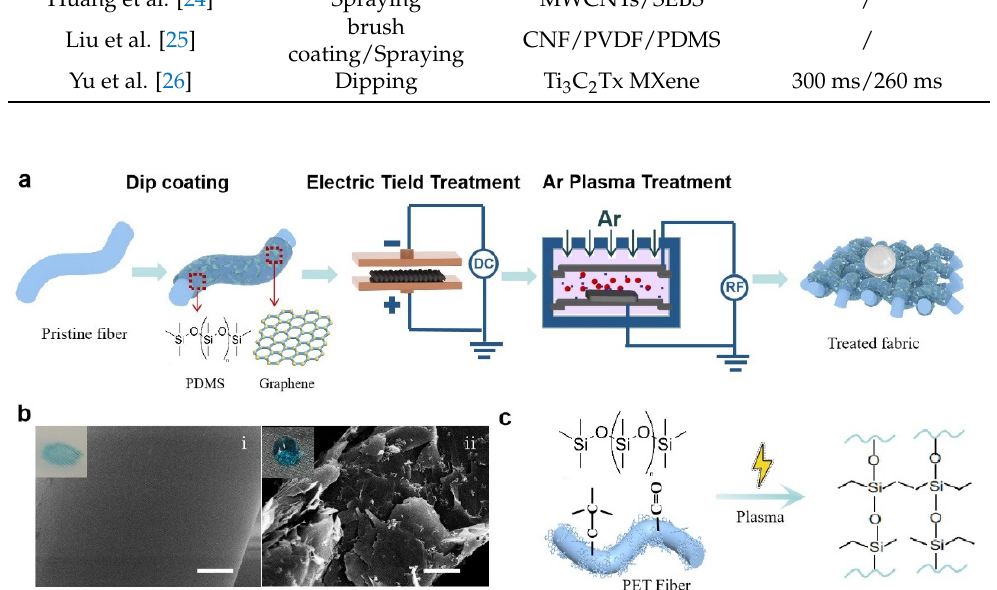
Figure 1. Preparation of superhydrophobic conductive fabrics. ( a ) Schematic diagram of the prepa- ration of superhydrophobic conductive fabrics by electric field, Ar plasma treatment. ( b ) Scanning electron microscope images show the surface morphology of the fibers before and after treatment, with the inset showing the state of the dyed water droplets on the fabric surface. ( i ) is untreated fabric, ( ii ) is the fabric after PDMS/graphene wrapping. Scale bar: 2.5 µ m. ( c ) Schematic diagram of the reaction principle between PDMS and polyester fibers in the plasma reaction chamber.